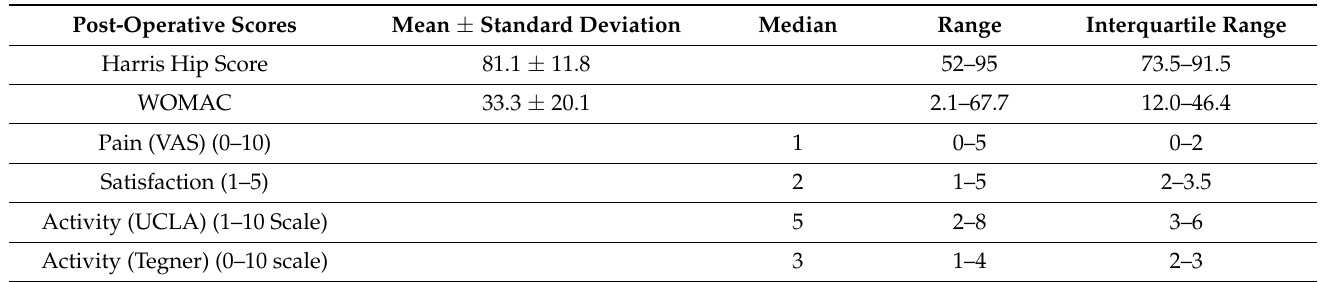
Table 4. Post-operative Function and Pain